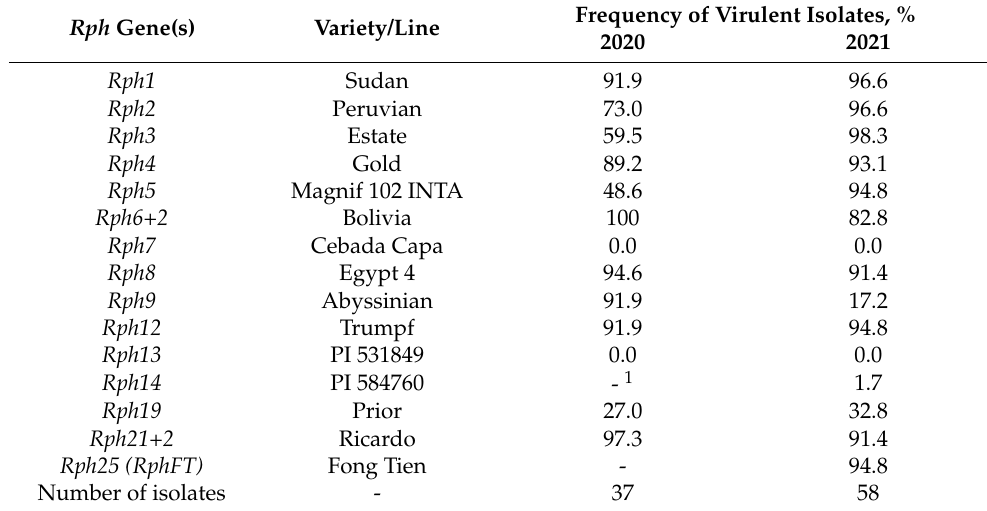
Table 2. Frequency of virulent monopustular isolates in the P. hordei population in Southern Russia (greenhouse, FRCBPP, 2020–2021 ГГ